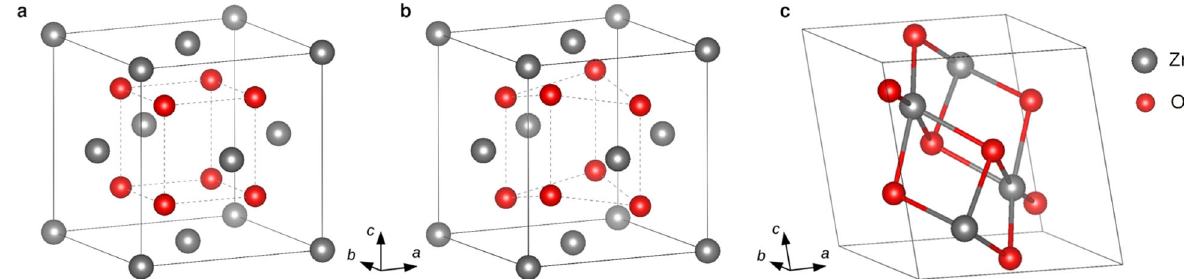
Fig. 1 Crystal structures of zirconia. Ball-and-stick model of the three structural phases of ZrO 2 : a cubic, b tetragonal, and c monoclinic. The 12-atom conventional cells are represented, and the Zr – O bonds are shown only in the monoclinic